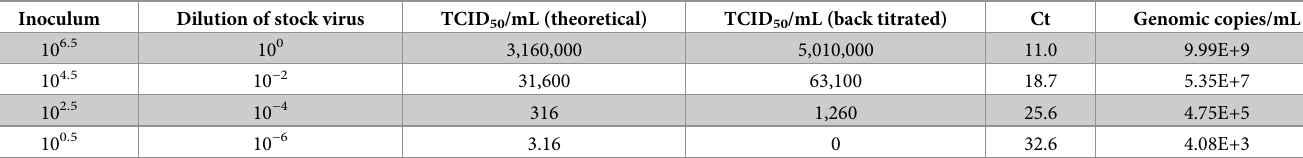
Table 1. Titers, PCR Ct values, and genomic copies/mL of virus dilutions used to inoculate finishing pigs. Inoculum Dilution of stock virus